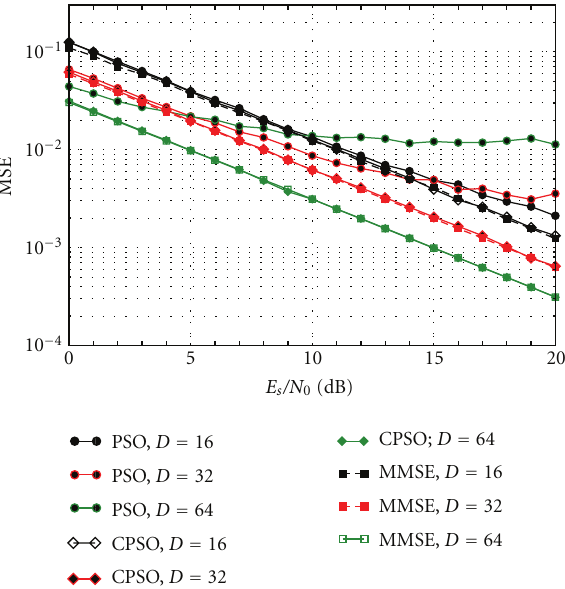
Figure 2: MSE performance of PSO and CPSO compared to MMSE channel estimation depending on the number of dimensions for a quasi-time-invariant Rayleigh fading